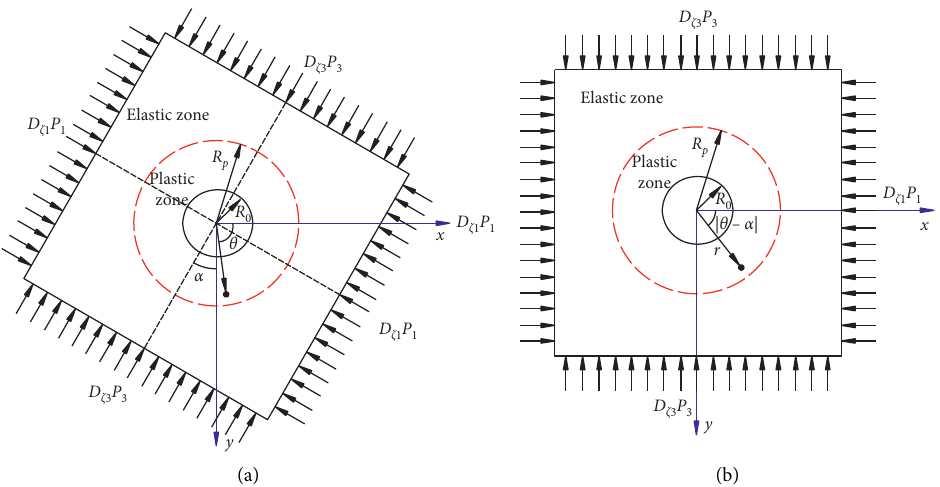
Figure 3: Mechanics model of the mining-influenced